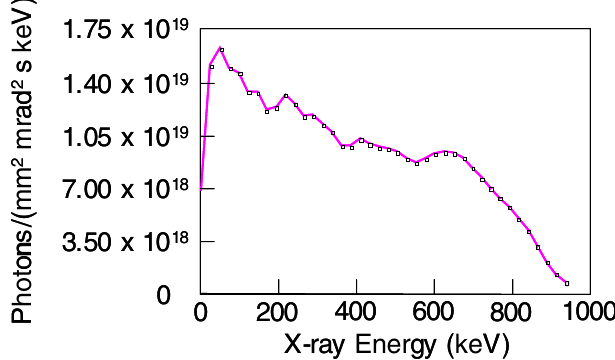
FIG. 4. (Color) On-axis x-ray spectrum, simulated by the three- dimensional time and frequency domain Compton scattering code, using the three-dimensional PIC code-generated electron beam phase space as an